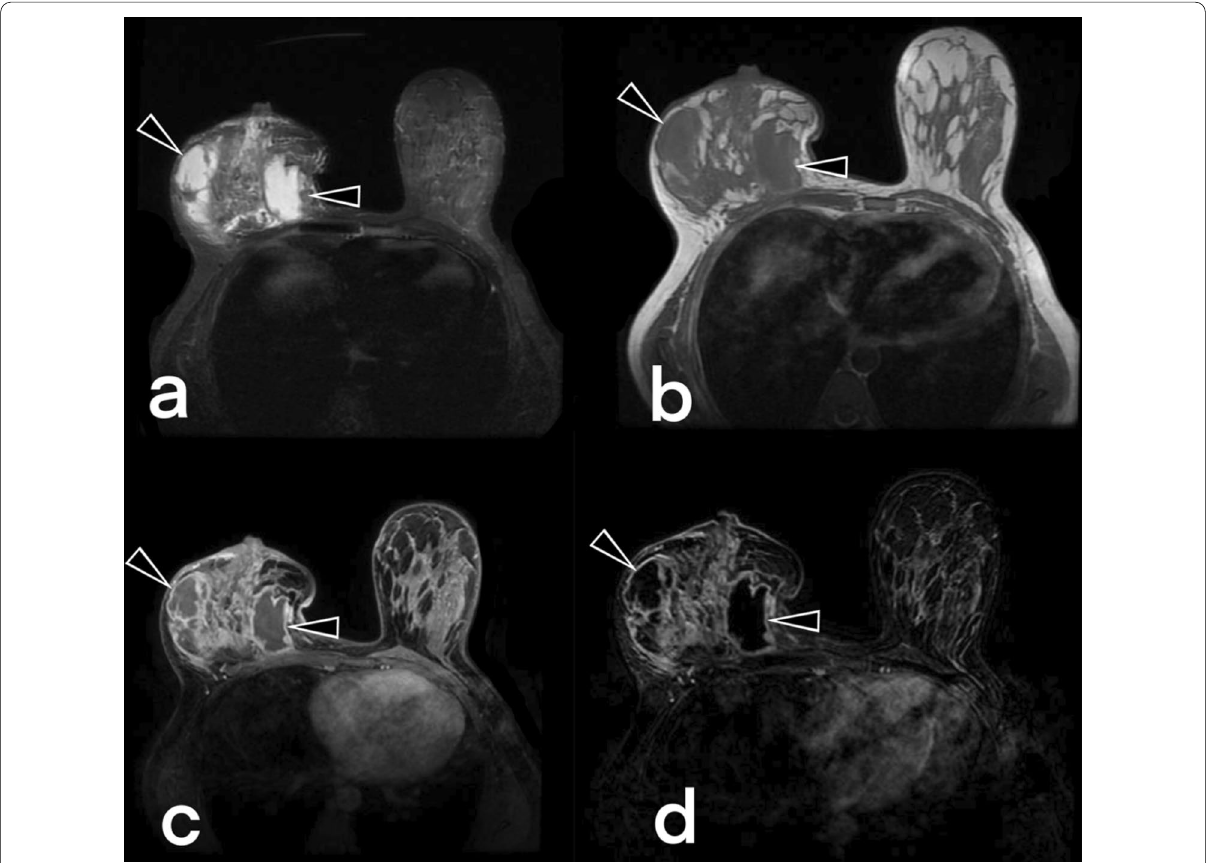
Fig. 10 Breast MRI images of a 39-year-old female. T2 weighted fat-suppressed image ( a ), T1 weighted image ( b ) post-contrast ( c ), and subtracted image ( d ) obtained at the late phase after intravenous gadolinium injection demonstrate multiple fluid collections (arrowheads) with peripheral enhancement in the right breast in keening with abscess. Diffuse involvement. BIRADS